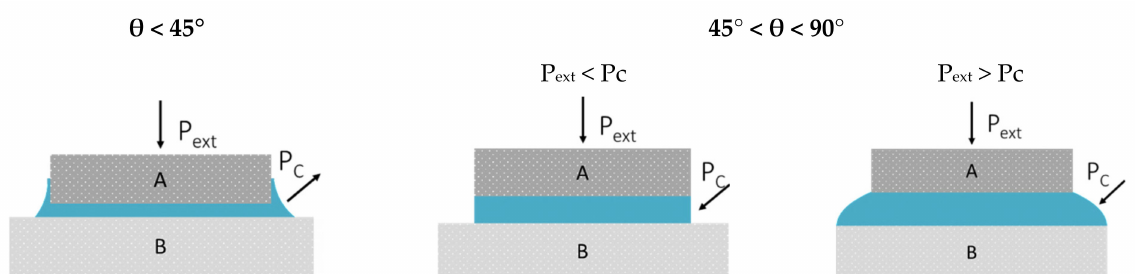
Figure 15. Relationship between wettability and weldability of the filler alloy P ext is the pressure exerted by the atmosphere on the substrate, Pc is the capillary force of the joint cavity and θ wetting angle. From left to right, when the contact angle is less than 45 ◦ , the entire joint cavity is filled and when 45 ◦ < θ < 90 ◦ , the formed liquid remains inside the joint and does not form a meniscus if the external pressure is lower or equal to the capillary force. Adapted from